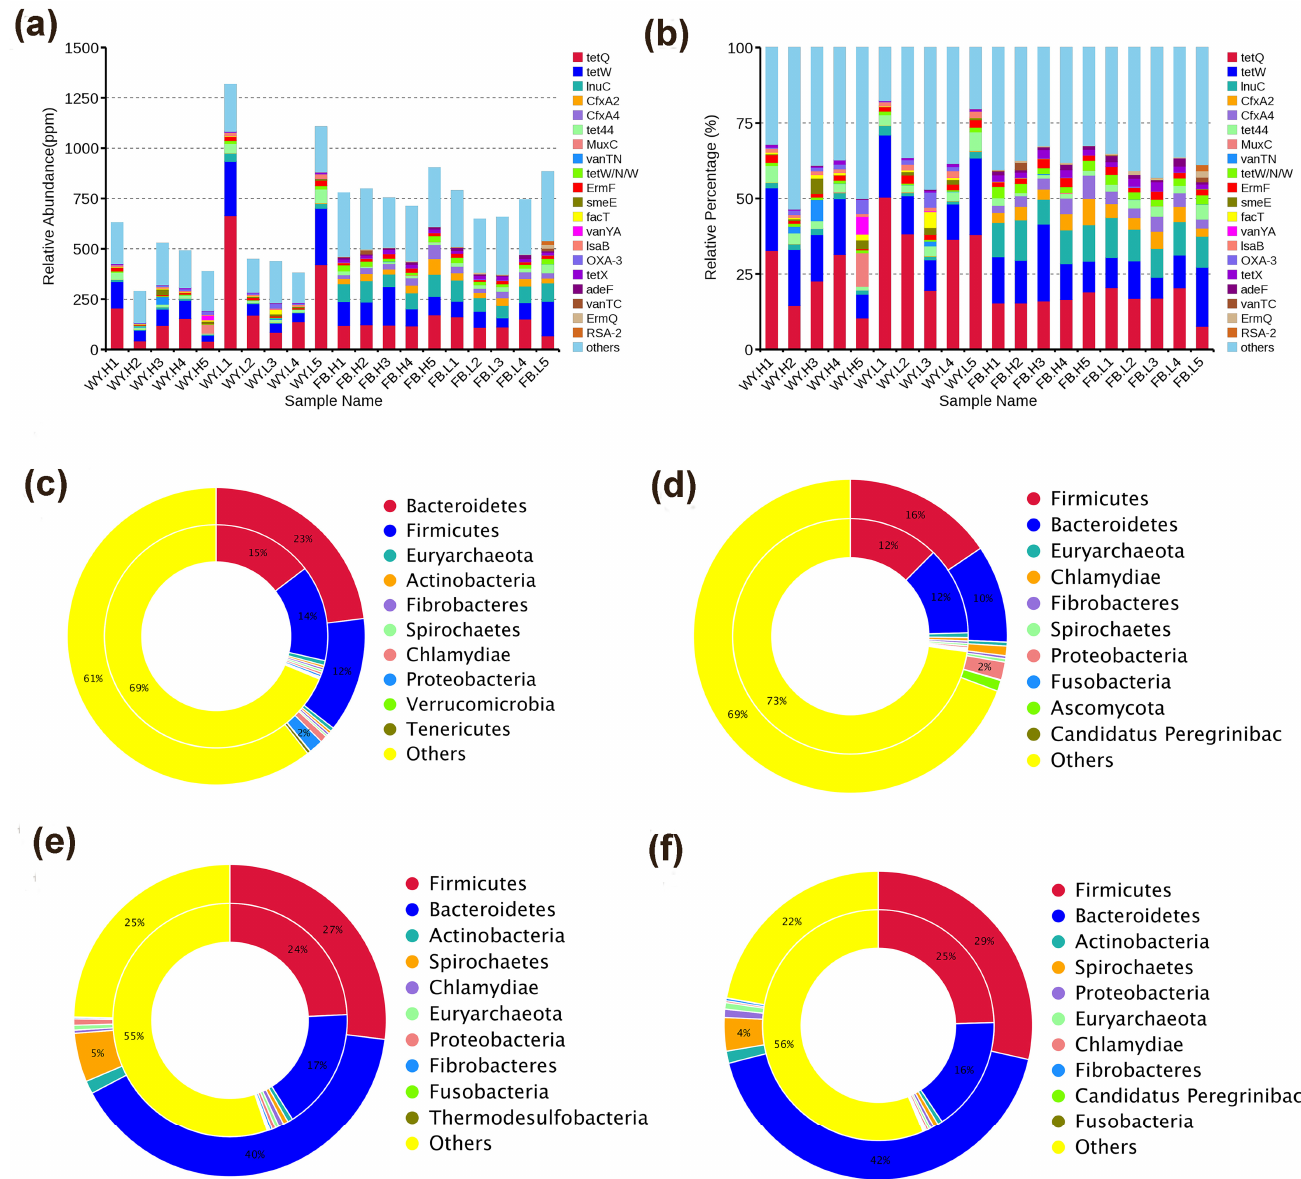
Figure 3. Analysis of antibiotic resistance genes; the inner circle shows the species distribution of AROs, and the outer circle shows the species distribution of all sample genes in the group. ( a ) Relative abundance of ARO in individual samples for all genes in ppm, owing to the magnification of the raw data of relative abundance by 106 times; ( b ) Relative abundance of the top 20 AROs in all AROs; ( c ) Source of LRFI rumen resistance genes; ( d ) Source of HRFI rumen resistance genes; ( e ) Source of LRFI fecal resistance genes; ( f ) Source of HRFI fecal resistance genes.